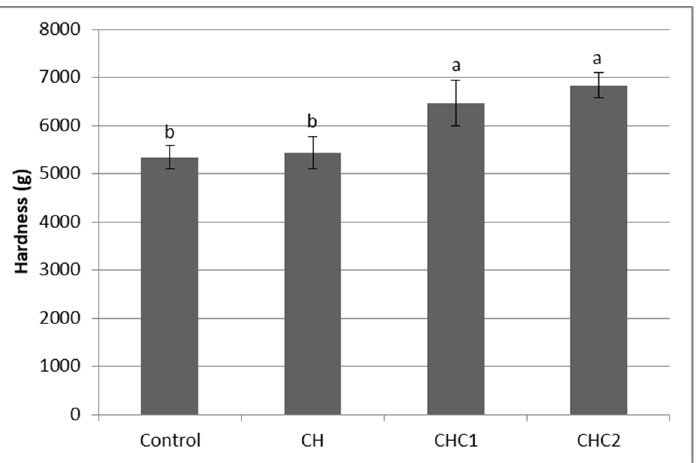
Figure 2. Hardness of developed reduced-fat gluten-free cookies (CH, CH1, CH2) compared with full-fat cookie (Control). Different small letters indicate statistical significance ( p < 0.05).